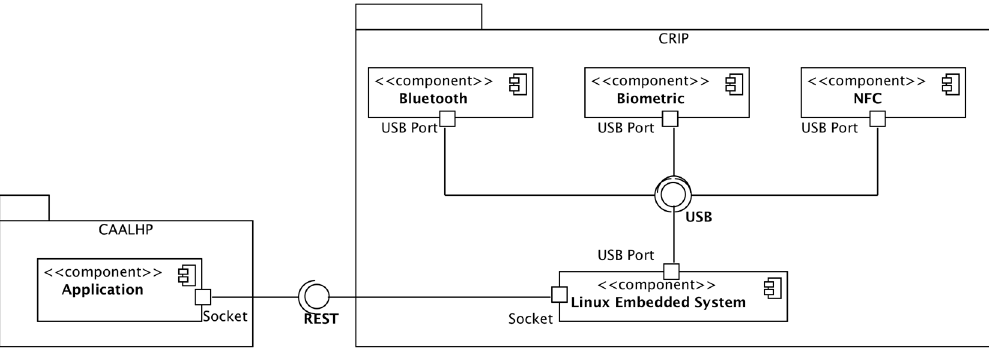
Figure 3. CRIP’s hardware architecture.